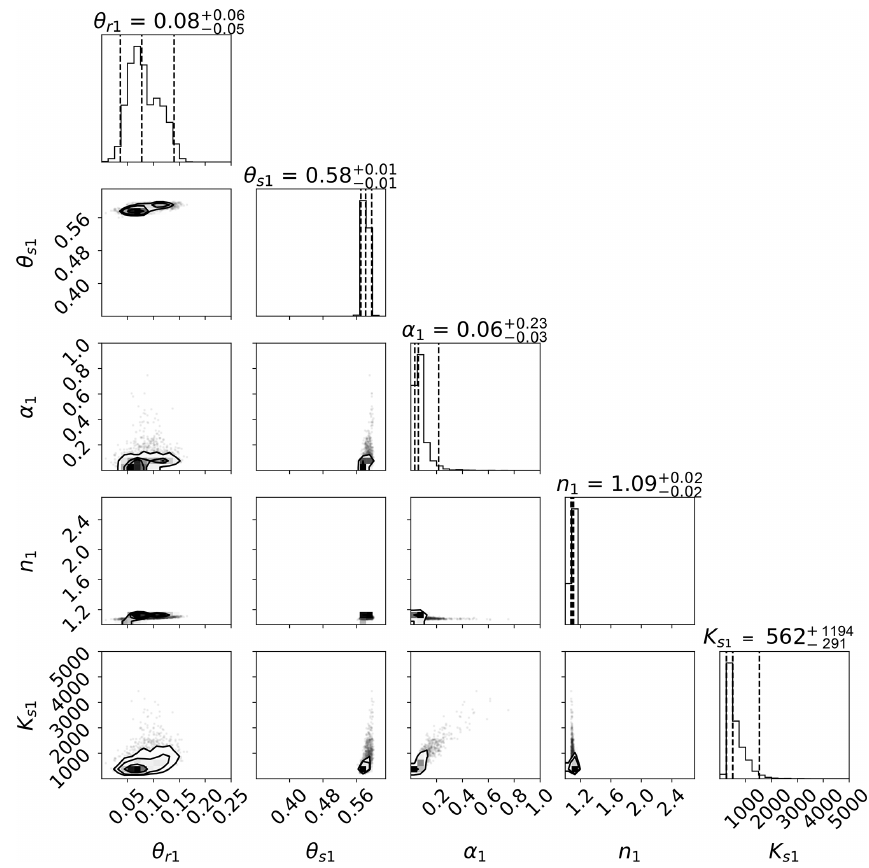
Figure 4. Marginal posterior distributions (one-dimensional projection on top of each column and joint distributions of each two parameters below) of estimated SHPs for the upper soil layer at Zettersfeld. Presented are the respective residual and saturated water content parameters θ r and θ s (cm 3 cm − 3 ), the VGM shape parameters α (cm − 1 ) and n (–), and the saturated hydraulic conductivity parameter K s (cmd − 1 ). The axis ranges correspond to the parameter bounds of the prior distribution. A close-up presentation of distributions with narrower axis ranges is shown in Fig. A3.